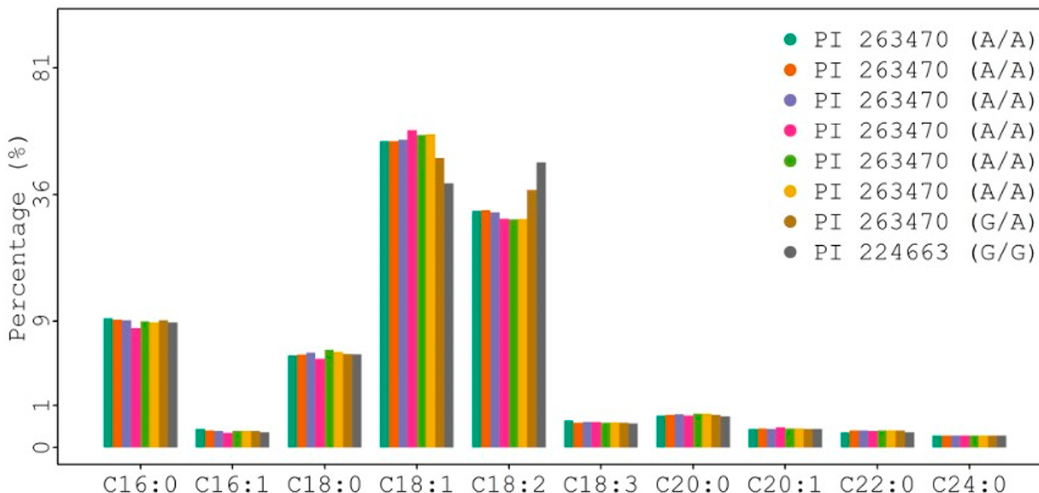
Figure 2. Comparison of fa tt y acid pro fi les among eight plants with FAD2 genotypes.